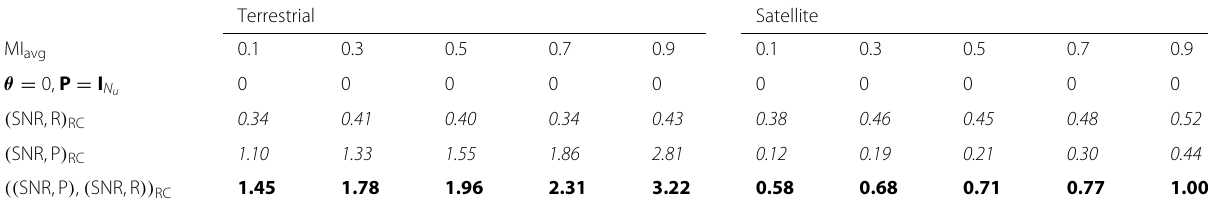
Table 2 SNR gain (dB) of the CD for 2-PAM Terrestrial Satellite